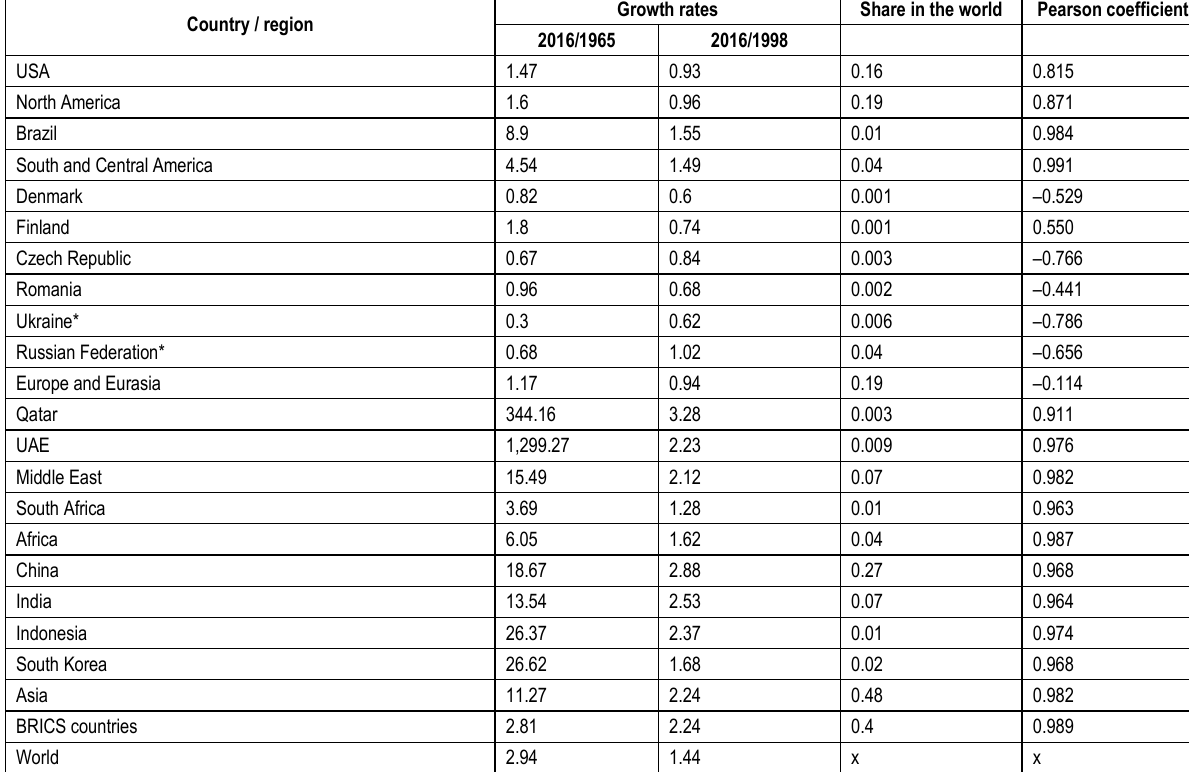
Table 1. СО2 emissions in the